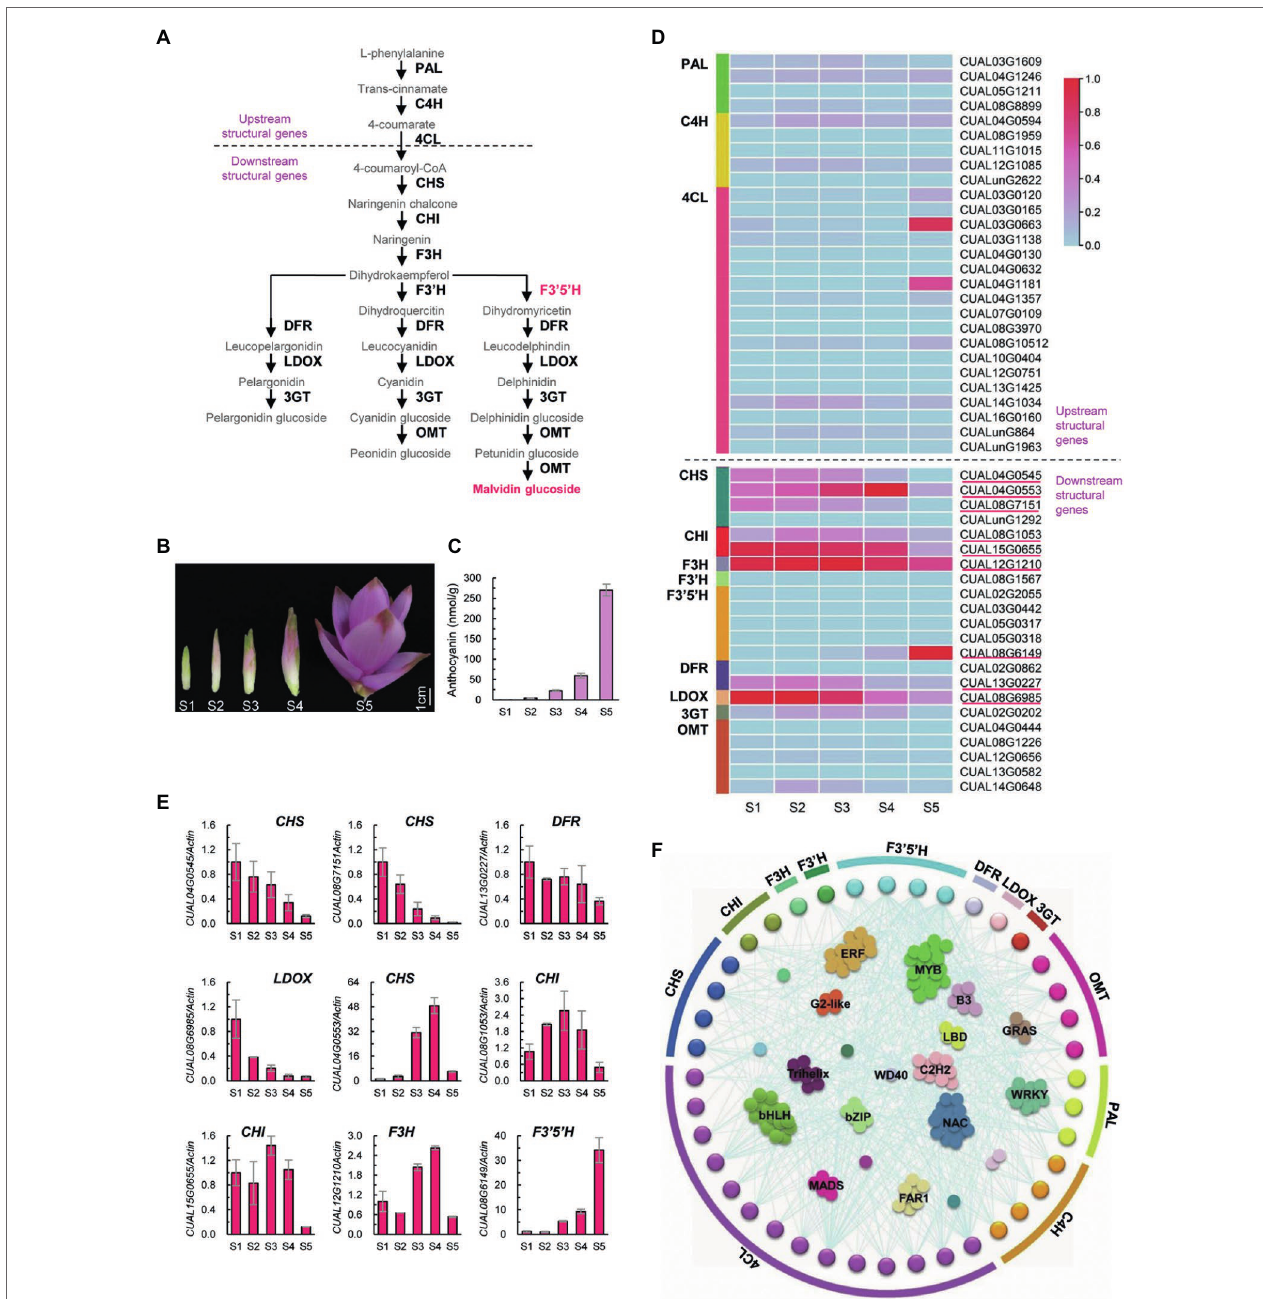
FIGURE 3 | Biosynthesis of anthocyanin in C. alismatifolia . (A) Biosynthesis pathways of anthocyanin. Structural genes in anthocyanin biosynthetic pathway were divided into two groups, designated as “upstream structural genes” and “downstream structural genes” respectively. The upstream structural genes are implicated in the biosynthesis of precursors of flavonoids, while the downstream structural genes are specifically involved in anthocyanin biosynthesis. Malvidin, the major anthocyanin in bract in C. alismatifolia , is marked in red. PAL, phenylalanine ammonia lyase; C4H, cinnamate 4-hydroxylase; 4CL, 4-coumarate CoA ligase; CHS, chalcone synthase; CHI, chalcone isomerase; F3H, flavanone 3-hydroxylase; F3 ′ H, flavonoid 3 ′ -hydroxylase; F3 ′ 5 ′ H, flavonoid 3 ′ ,5 ′ hydroxylase; DRF, dihydroflavonol 4-reductase; LDOX, leucoanthocyanidin dioxygenase; 3GT, UDP-glucose flavonoid 3-glucosyltransferase; and OMT, O-methyltransferases. (B) Distal bracts from five developmental stages. From left to right, youngest to oldest (S1–S5). (C) Anthocyanin contents in the distal bracts collected from the five stages. (D) Expression heatmap of the 49 structural genes at different stages of bract development. The expression values at the column scale were z-score normalized. Low to high expression is indicated by a change in color from blue to red. The nine highly expressed downstream genes are marked with red lines. (E) Real-time PCR analysis of the nine downstream structural genes with high transcription levels. The expression levels were normalized to Actin1 ( CUAL02G1340 ) and related to stage 1. Data are presented in mean ± SD ( n = 3). (F) The co-expression network of the structural genes with transcription